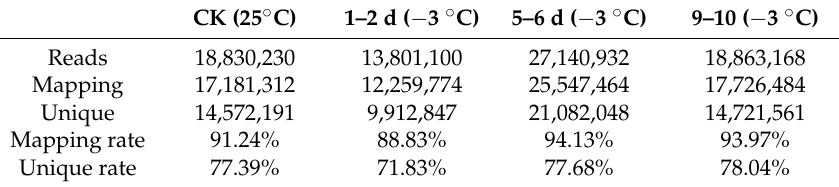
Table 3. Clean reads mapping to